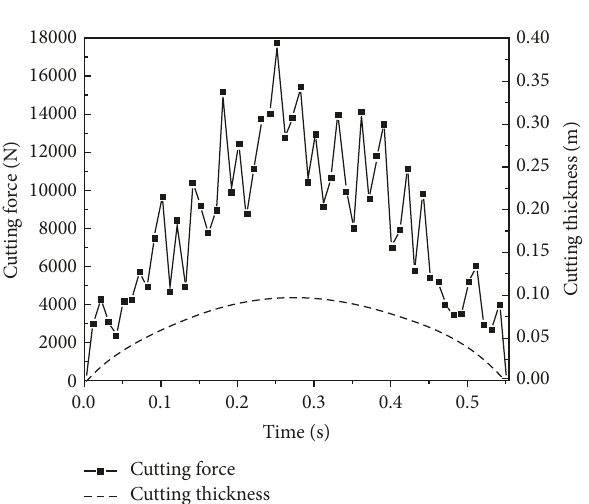
Figure 11: Cutting force of conical pick under the cutting parameter G